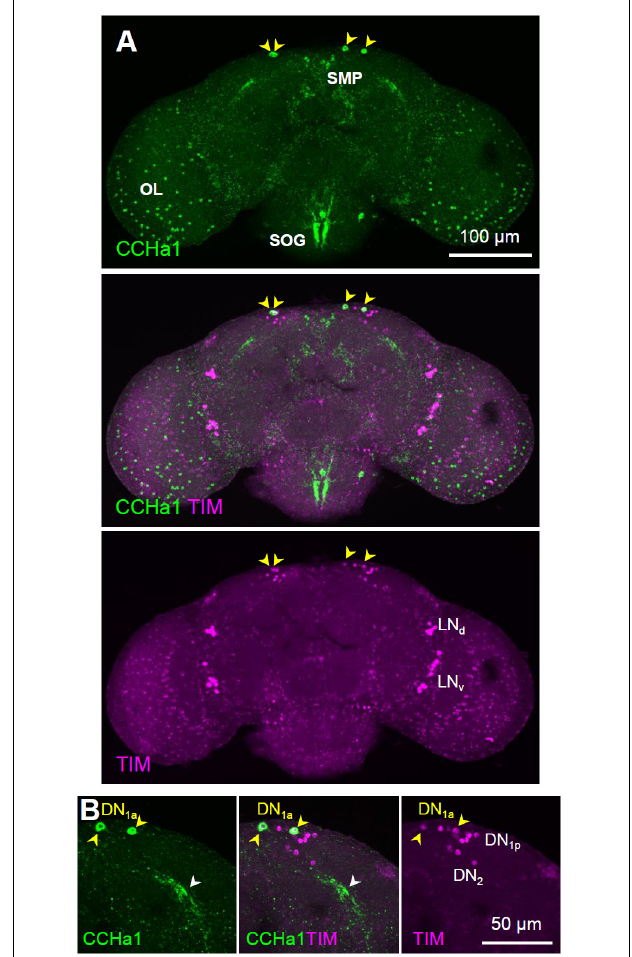
FIGURE 1 | CCHa1 expression in the DN 1a clock neurons. (A) Double staining with anti-CCHa1 (green) and anti-TIM (magenta) antibodies revealed that only the DN 1a neurons (yellow arrowheads) express CCHa1; CCHa1 is also expressed in the entire optic lobe (OL) and in the cells around the superior medial protocerebrum (SMP) and suboesophageal ganglion (SOG). (B) An enlarged image of the DN 1a neurons. Yellow arrowheads and the white arrowhead indicate the cell bodies of the DN 1a neurons and their projections, respectively. CCHa1, CCHamide1; DN 1a , anterior dorsal neuron 1; LN d , dorsal lateral neuron; LN v , ventral lateral